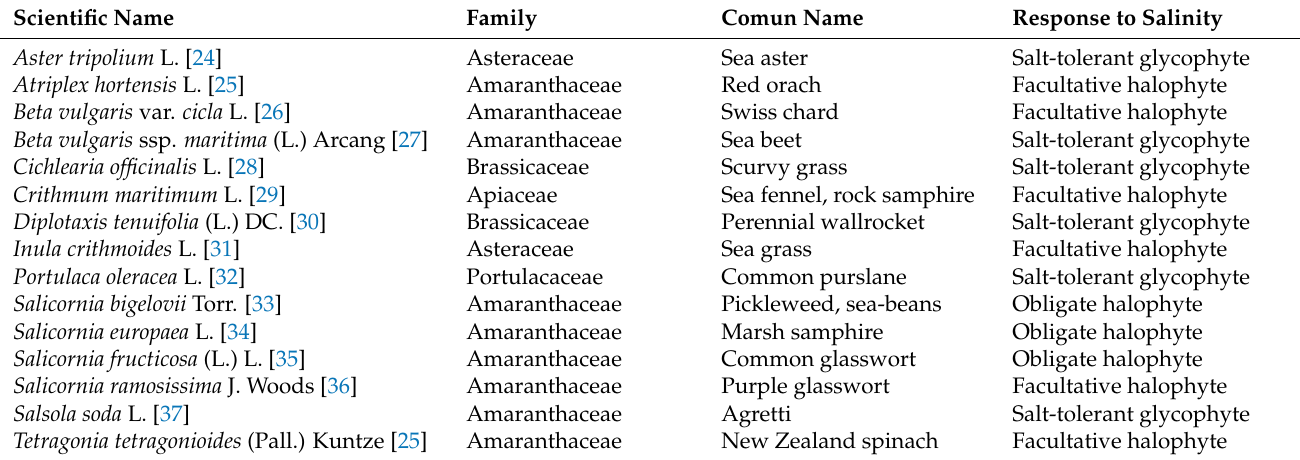
Table 1. Species assessed for the selection of suitable species for saltwater aquaponics using DEXi method.